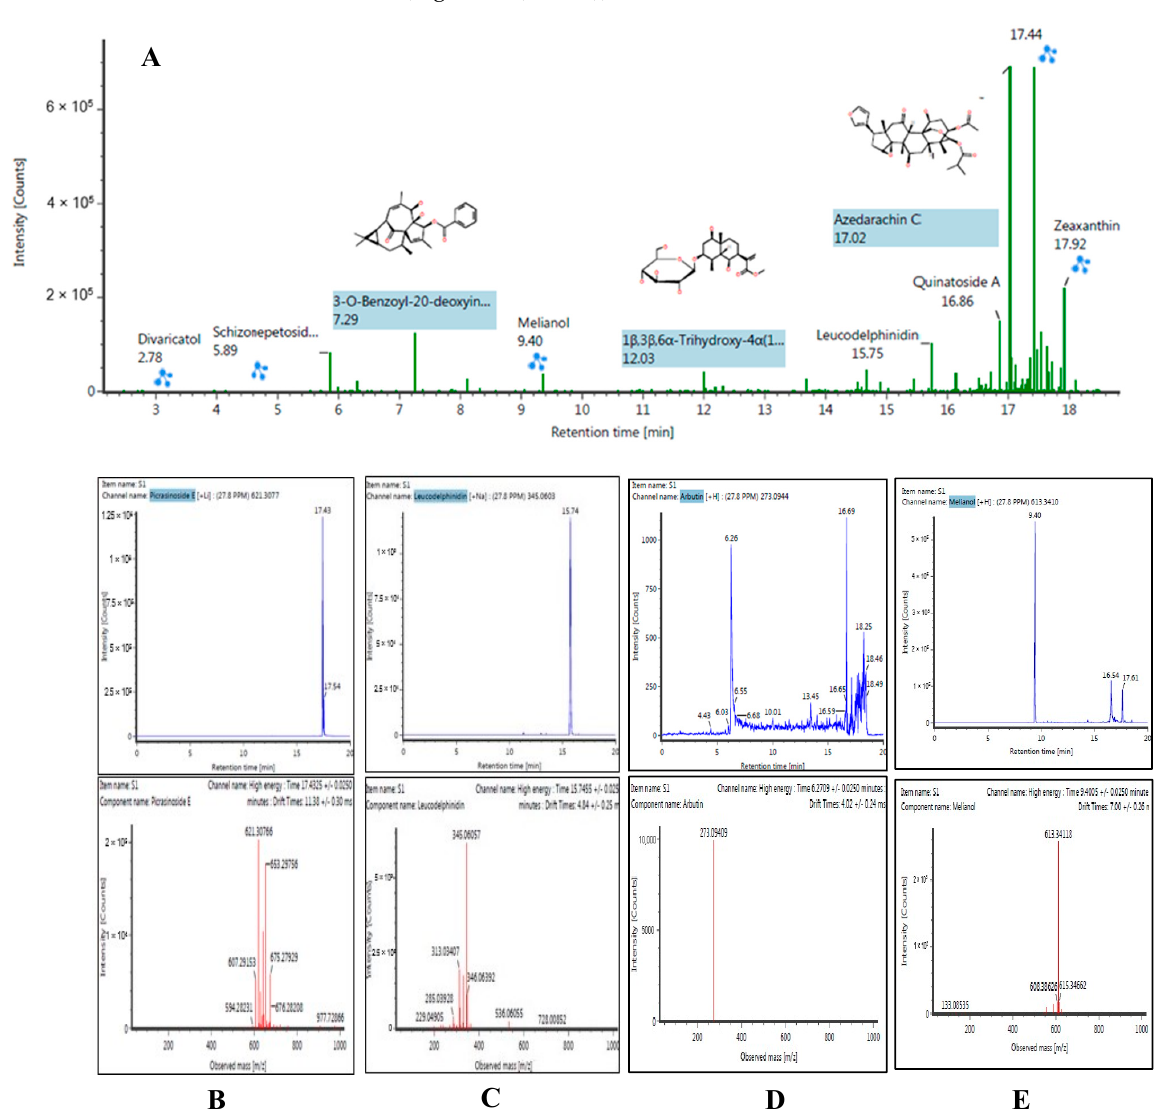
Figure 5. ( A ) Full chromatogram of CILEx in negative ion mode. LC chromatograms and mass spectra of CILEx for high-intensity compounds identified and vertically arranged as ( B ) picrasinoside E, ( C ) schizonepetoside E, ( D ) melianol, and ( E )